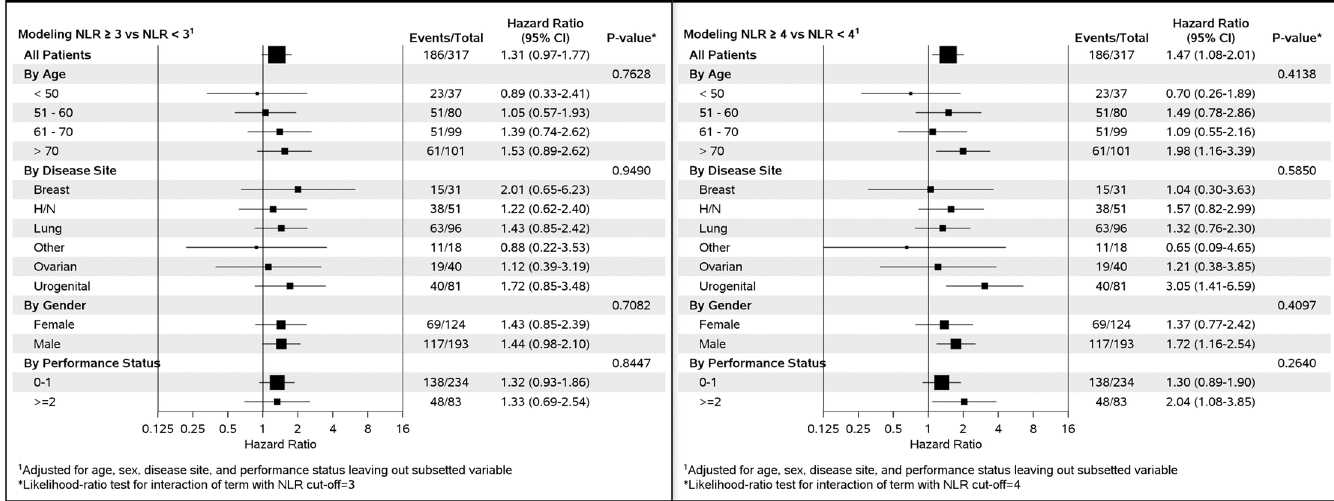
Fig 3. Subgroup analysis illustrating the impact of the choice of neutrophil-to-lymphocyte ratio (NLR) cut-off value; examples with NLR (cid:21) 3.0 ( A ) and NLR (cid:21) 4.0 ( B ). The model was adjusted for age, sex, disease site and European Co-operative Oncology Group performance status, and the interaction test remained statistically non- significant across the different subgroups, irrespective of the cut-off value, in favour of a persisting negative effect of a high NLR value on prognosis. (cid:3) Likelihood-ratio txt for interaction of term with NLR cut-off = 3.